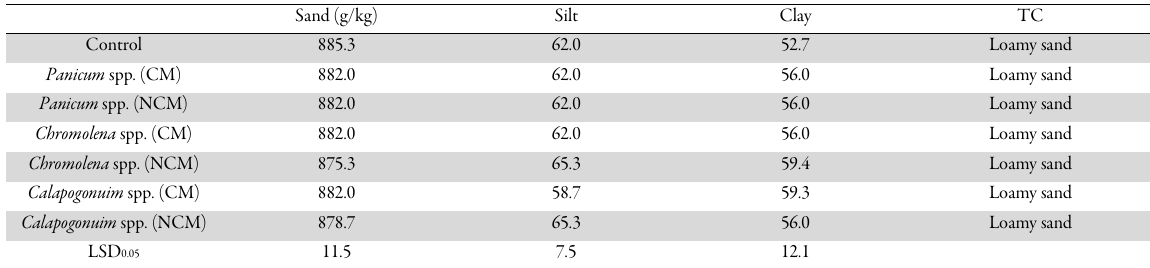
Table 1. Particle size distribution of soils